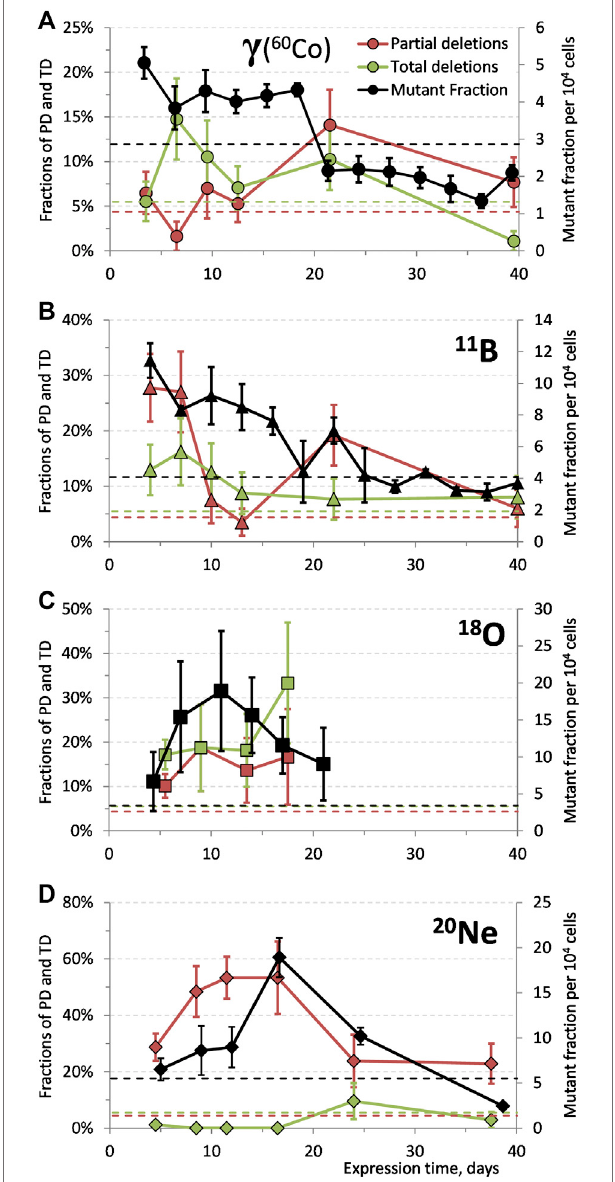
FIGURE 4 | Dependences of fractions of partial and total deletions (average of used doses), and mutant fraction on expression time for HPRT mutants induced by (A) gamma radiation ( 60 Co), (B) 11 B ions, (C) 18 O ions, and (D) 20 Ne ions. Dashed horizontal lines represent levels of spontaneous mutants: red line, partial deletions; green line, total deletions; black line, mutant fraction. The data points were connected to guide the eye. Data for mutant fraction were taken from our previous work [32]. Error bars represent standard error of the mean.